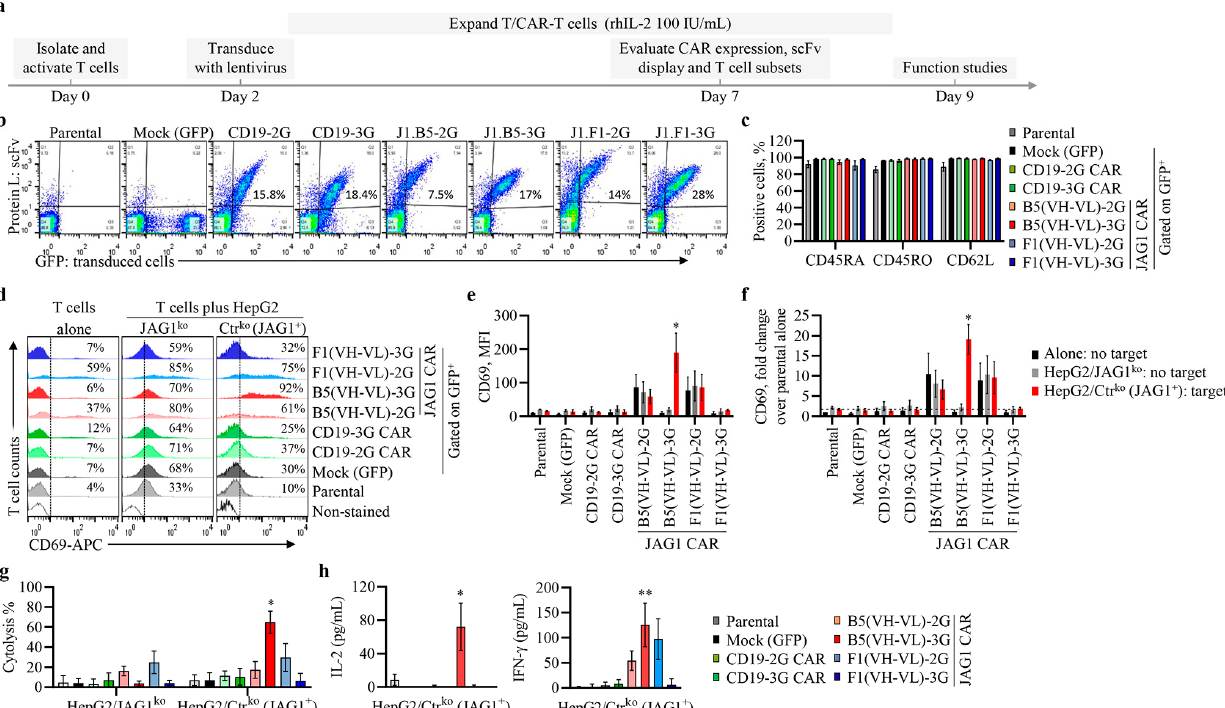
Figure 5. Expression, activation, and killing activities of anti-JAG1 CARs in primary T cells. ( a ) Schematic diagram of CAR-T cells’ generation and characterization from three different donors. ( b ) Surface expression of CARs in transduced CAR-T cells, defined as GFP + cells, by protein L binding detection. Nontransduced and mock-transduced cells were used as negative controls. Data are representative from assays with cells from three donors ( c ) Mean percentage (±SEM) of the indicated T-cell phenotype markers in nontransduced parental cells, gated GFP-positive mock, or CAR-T cells from three donors. ( d – f ) Expression of T-cell activation marker CD69 in T/CAR-T cells from three donors cultured alone or with HepG2 JAG1-negative (HepG2/JAG1 ko ) or JAG1-positive